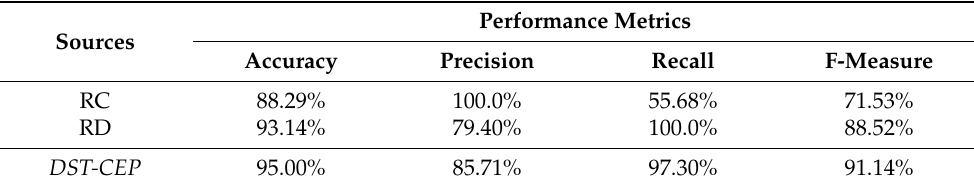
Table 6. Results of performance metrics of conjunction and disjunction rules without uncertainty.